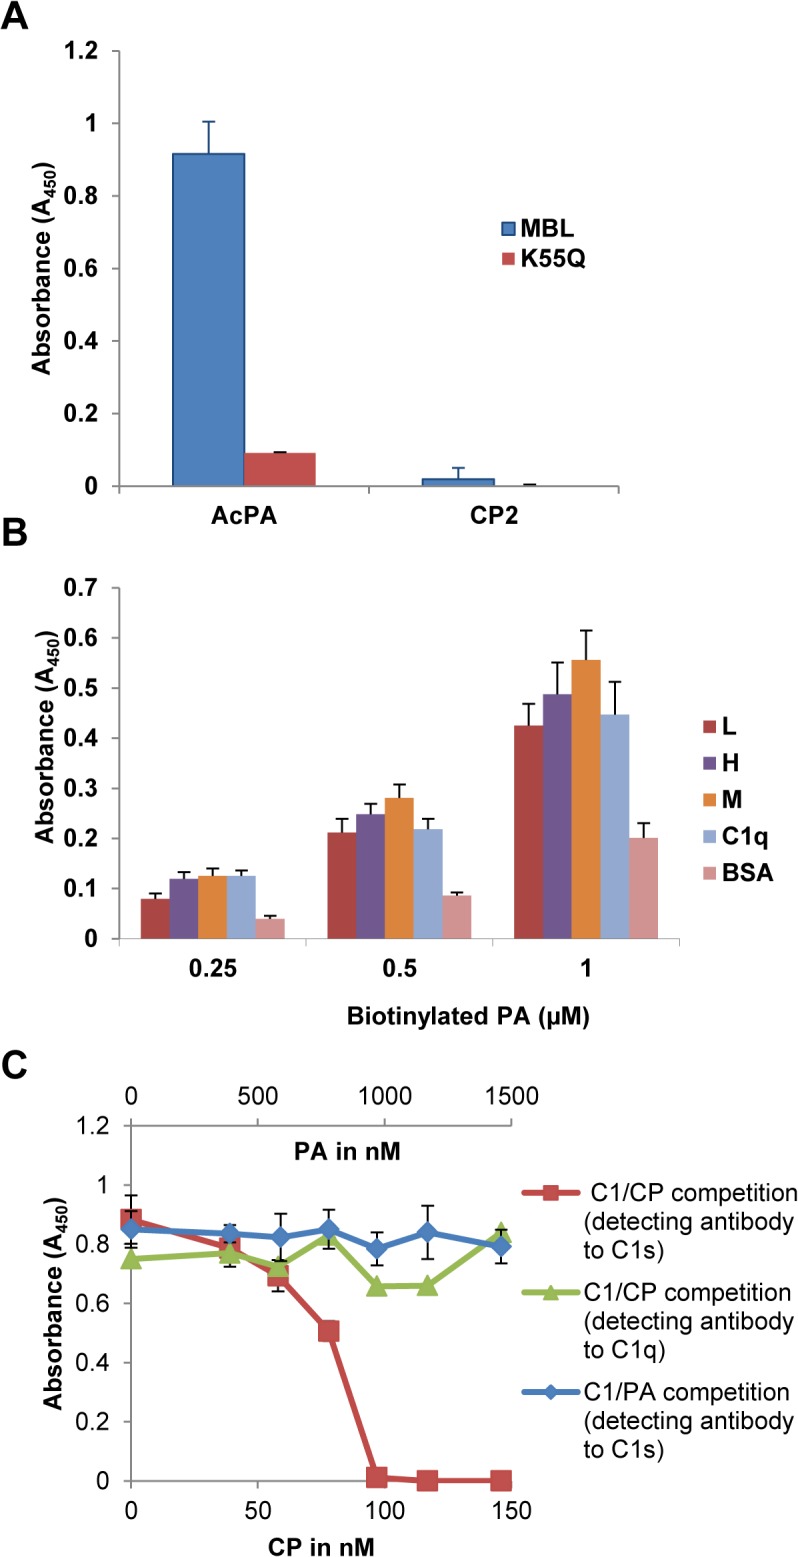
PA binds to MBL and ficolins and does not displace C1s from C1q.(A) The AcPA and CP2 peptides were adsorbed to a microtiter plate and incubated with a constant amount of MBL or K55Q. Bound MBL was detected with a polyclonal goat anti-MBL sera followed by HRP-conjugated anti-goat sera. (B) The various ficolins indicated in the figure were adsorbed to the microtiter plate and incubated with biotinylated PA followed by a neutravidin conjugate. BSA was used as a negative control for binding. (C) Partially purified C1 was mixed with increasing amounts of CP or PA and added to a microtiter plate coated with monoclonal antibody to C1q. After washing, C1s signal present in intact C1 complexes was measured by ELISA using polyclonal antibody to C1s (CP, red line; PA, blue line) or polyclonal antibody to C1q (green line) to confirm C1q was bound to the plate. Data represent the means of three independent experiments. Error bars denote SEM.